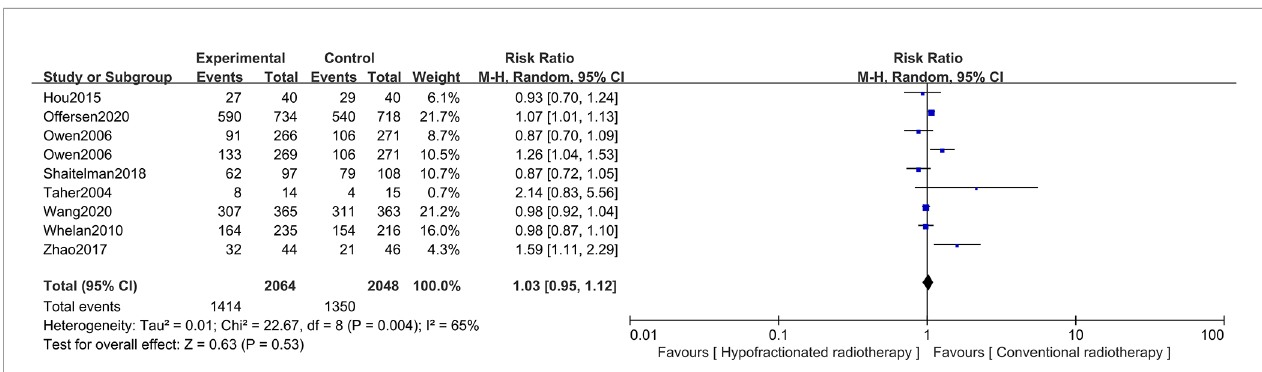
FIGURE 5 | Forest plot of hypofractionated radiotherapy (HFRT) vs . conventional radiotherapy (CFRT) for cosmetic outcomes ( p =